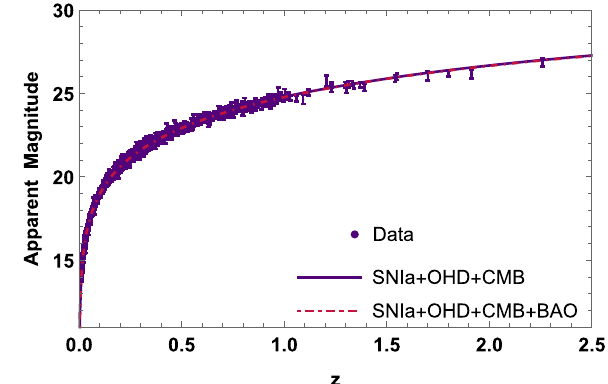
Fig. 3 The evolution of apparent magnitude with redshift for the best estimated values of the model parameters using the fourth and sixth datasets, compared with type Ia SNe data